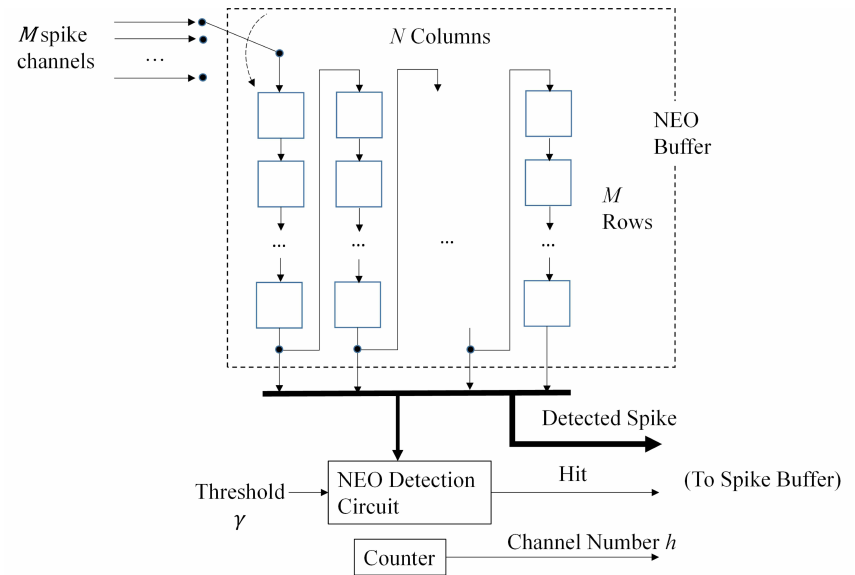
Figure 14. The architecture of the multi-channel NEO